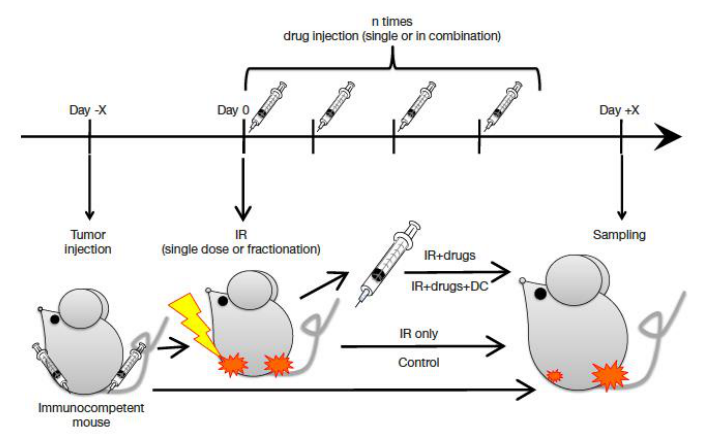
Figure 12. Typical protocol used in various laboratories to compare C-ions and X-rays in combination to immunotherapy. Reproduced from ref. [295], distributed under Creative Commons CC-BY.